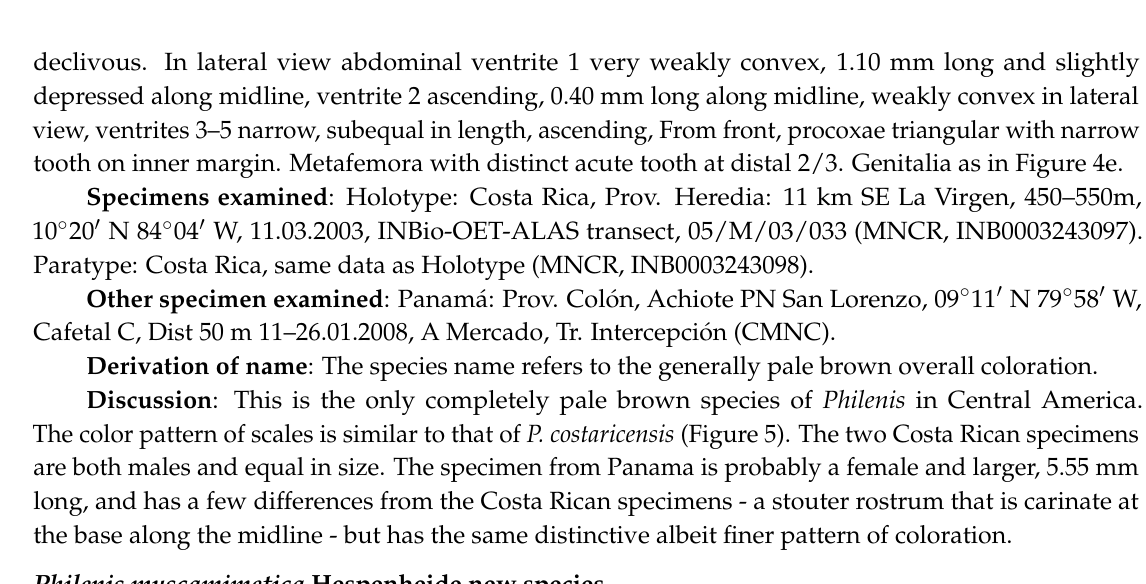
Description : Holotype: body size 5.75 mm long, 3.00 mm wide. Moderately robust, elliptical, somewhat narrower anteriorly, black throughout, except elytral disc reddish brown; sparsely to somewhat densely covered with scales: scales orange-red on vertex of head posterior to eyes and on anterior 1 / 2 of pronotum dorsally extending on sides to middle of eyes; scales dense and yellowish on frons and on rostrum to antennal insertions; scales pale sparse brown on disc of pronotum; scales pale yellowish-brown on ventral 1/2 of procoxae, in narrow line on midline of basal 1/4 of pronotum, in narrow line along base of elytra, on interval 2 along suture for length of elytra, in narrow line along apices of elytra and in spots on intervals 9 and 10 at basal 1/4 of elytra and intervals 8–10 at apical 3/4 of elytra; scales white in broad irregular line from posterior angles of pronotum to posterior edge of red scales and along anterior edge of sides of pronotum to procoxae, on mesepisterna, dorsal 1/2 of epimera, middle 2/3 of metepistera, and metasternum; scales white in broadly triangular area on sides of abdominal ventrite, 1, on posterolateral 1/2 of ventrite 2, and on lateral 1/3 of ventrites 3–5, and on basal 1/2 of ventral surfaces of meso- and metafemora; elsewhere scales are dark brown or black or minute and